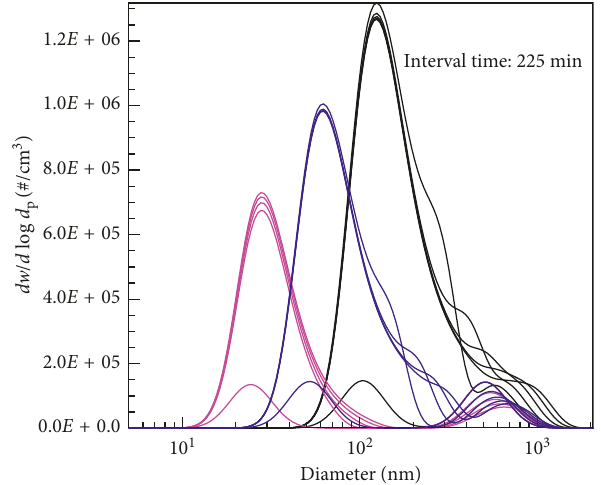
(nm)0.0 Diameter Figure 4: Comparison of NSD with interval time of 225min for sources (1, 2, and 3) (black, blue, and purple) at the same back- ground particles with its GMD of 500nm, TPN of 4.34 10 10 #/m 3 , × and GSD of 1.32. Although all three sources have the same TPN, the particle number concentration for SP mode at steady state is in- creased with the increase of source GMD.